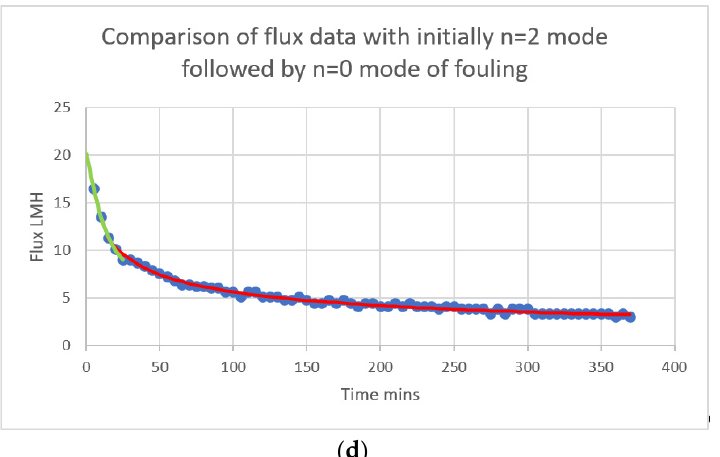
Figure 4. ( a ) Initial plot of data to determine overall possibilities; ( b ) Data used in 𝑅(𝑡) format to check on breakpoint from one mode to the next; ( c ) Evaluation of most appropriate mechanism for modelling of second phase; ( d ) final output with data shown in blue.